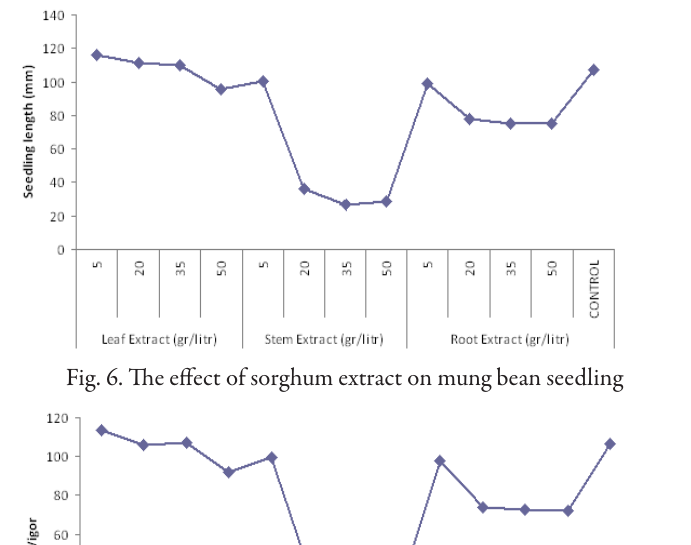
Fig. 6. The effect of sorghum extract on mung bean seedling